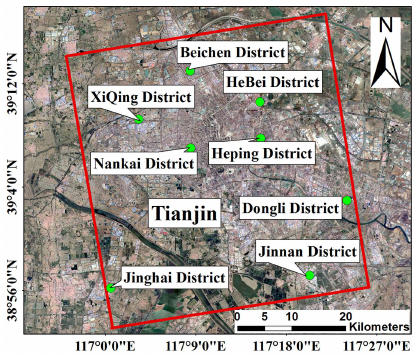
Figure 1. Geographical extent of the study